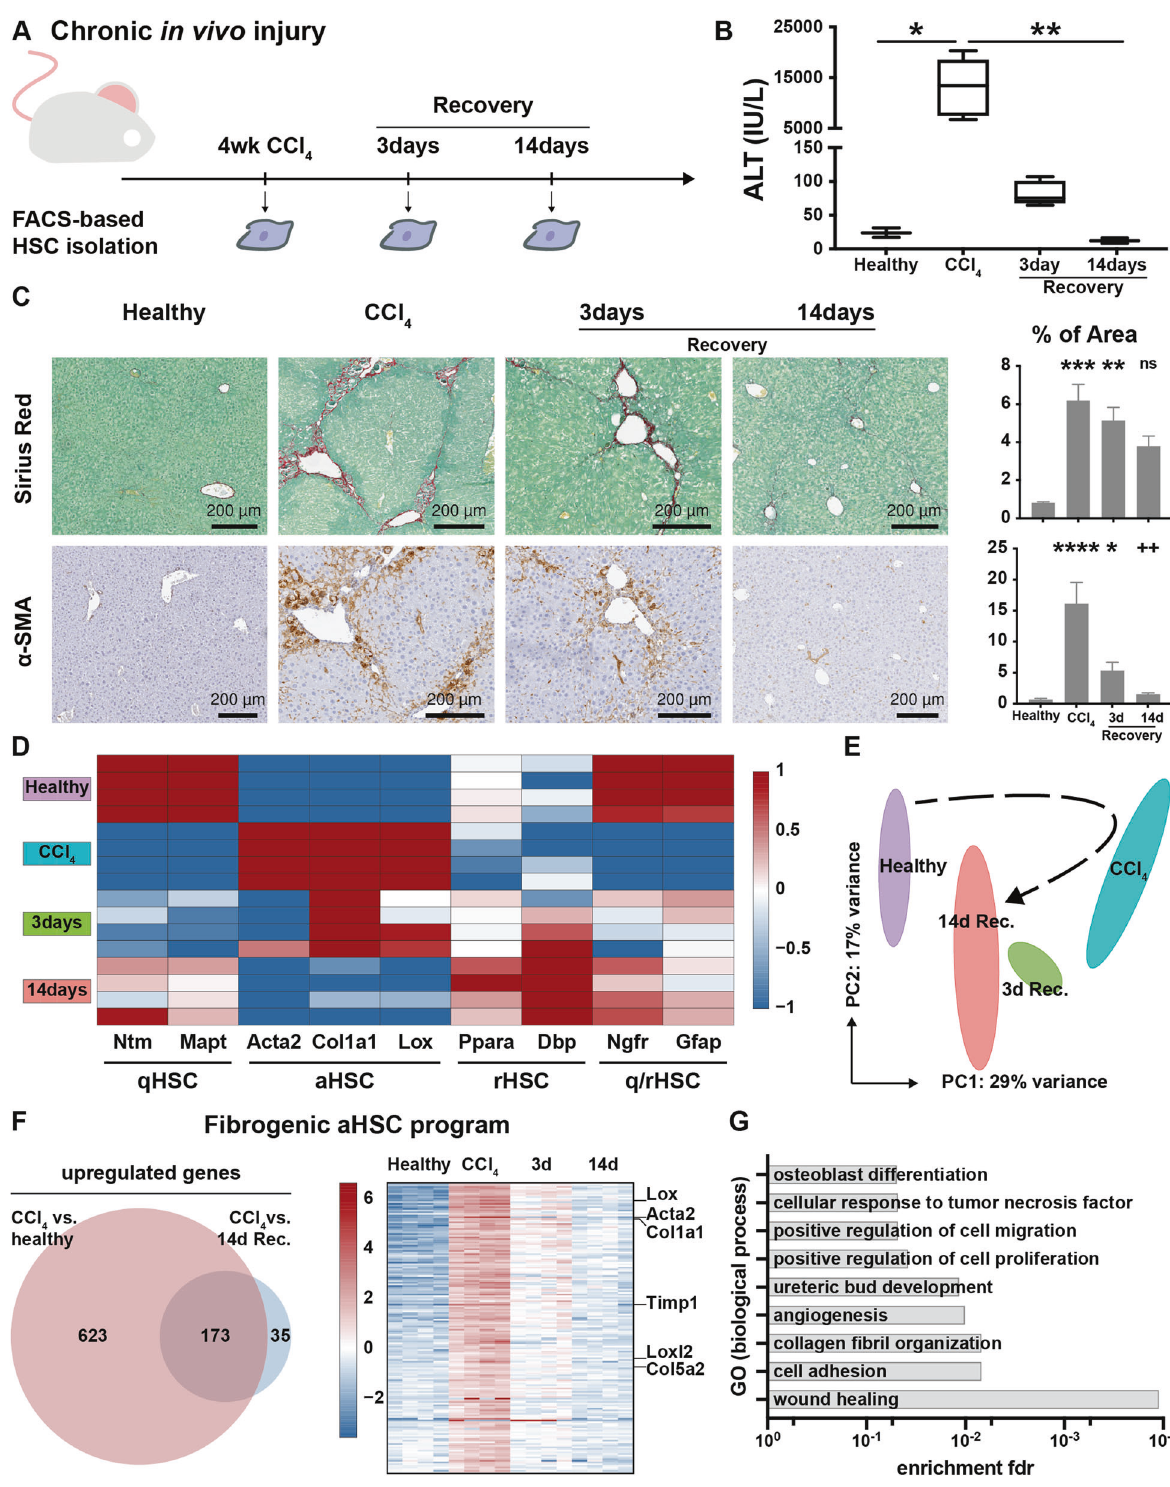
Fig. 1 Generation of a fi brogenic aHSC program based on the CCl 4 model of liver fi brosis and reversal. A Mice were injected with CCl 4 for 4 weeks. HSCs were FACS-isolated at indicated timepoints and their RNA subjected to bulk sequencing. As a control, healthy (non-injected) mice were used. B ALT values indicate chronic liver injury and recovery. C Sirius red and α -SMA staining show fi brosis development and reversal. Barplots represent quanti fi cation of positive area. D Expression of phenotype speci fi c genes during fi brosis induction and reversal. E Global transcriptional alterations of isolated HSCs by PC analysis. F Generation of the fi brogenic aHSC program. Differentially expressed genes in HSCs isolated from CCl 4 treated mice compared to HSCs isolated from both healthy and recovered mice. Heatmap represents the de fi ned 173 genes pinpointed as peak fi brosis genes. G GO analysis (biological process) of the fi brogenic aHSC program. ns p > 0.05, * p < 0.05, ** p < 0.01, *** p < 0.001.